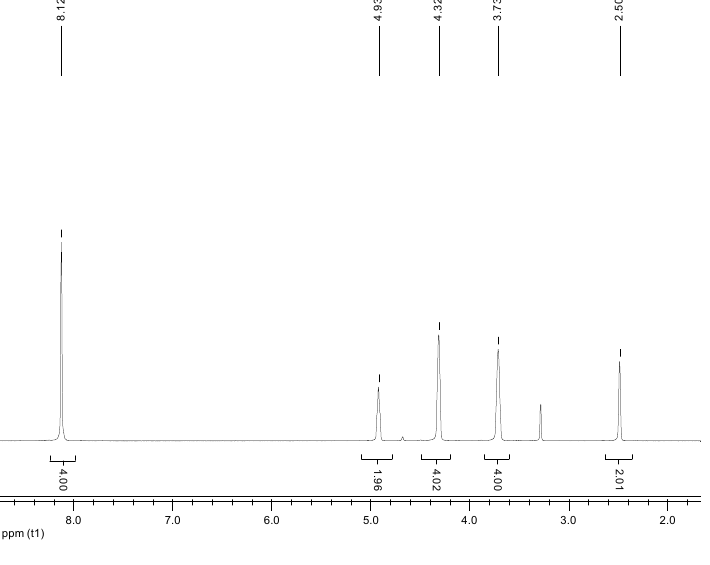
Figure 2. 1 H-NMR spectrum of [Bmim]ZnCl